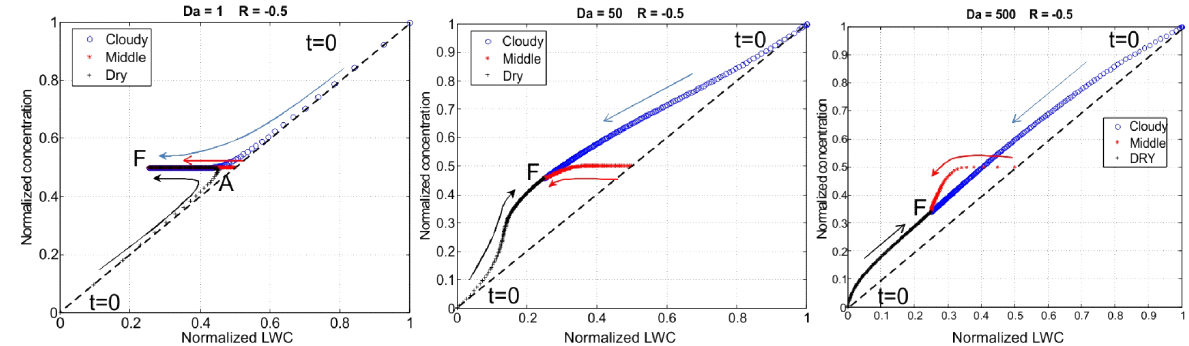
Figure 10. Dependencies of normalized values of droplet concentration on normalized LWC at different Da and at R = − 0 . 5. Blue circles mark the center of the cloudy volume ( e x = 1 / 4 ) , red symbols mark the initial interface ( e x = 1 / 2 ) and black crosses mark the center of the initially dry volume ( e x = 3 / 4 ) . Arrows show the direction of movement of the points with time. Point “F” marks the final stationary state of the system. The dashed line indicates the relationship between e N and e q in extremely inhomogeneous mixing (according to the classical concept).